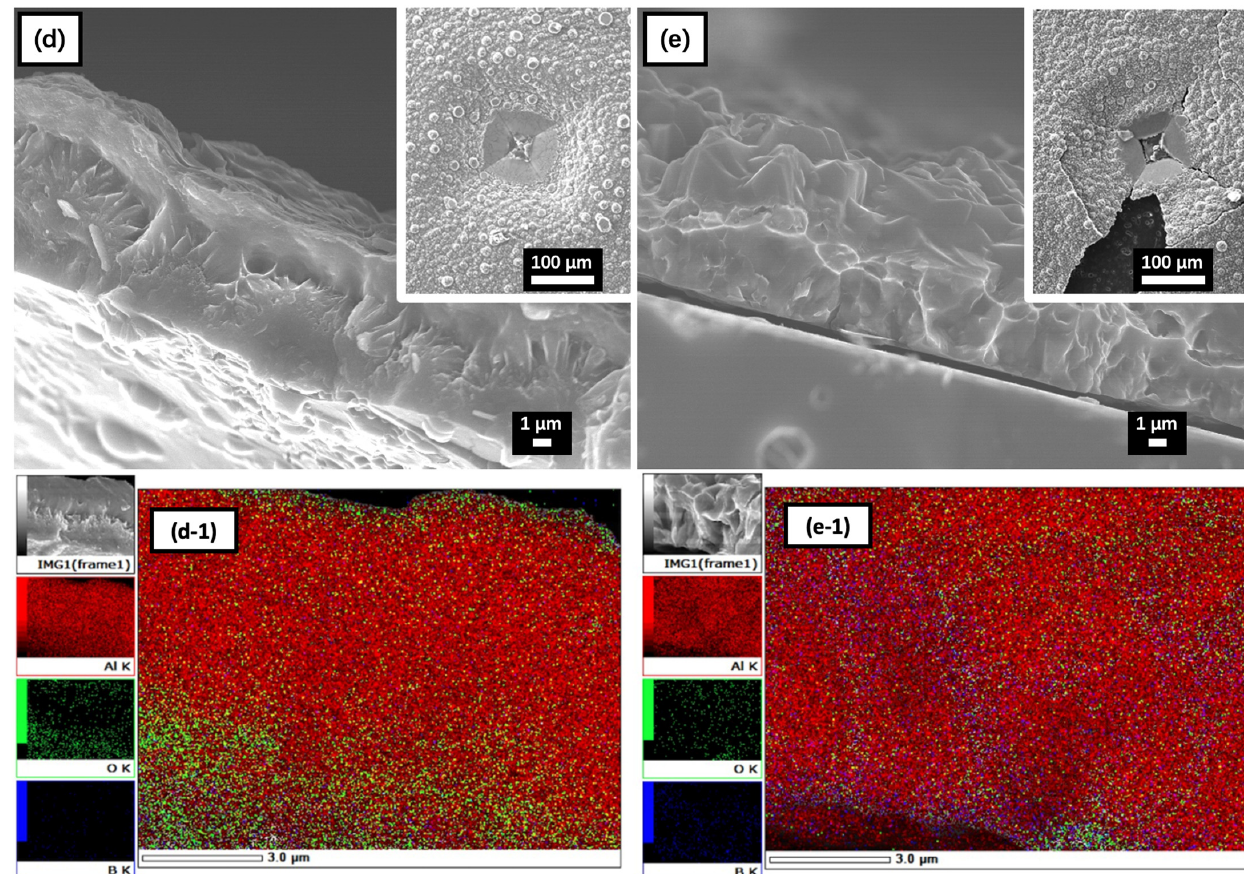
Figure 7. Observation results of cracks in sample dAl-5 are ( a , b , c ); ( d , e ) are cross-sectional observation results of dAl-2 and dAl-5, respectively; ( d-1 ) and ( e-1 ) EDS mapping images of cross-sectional observation.